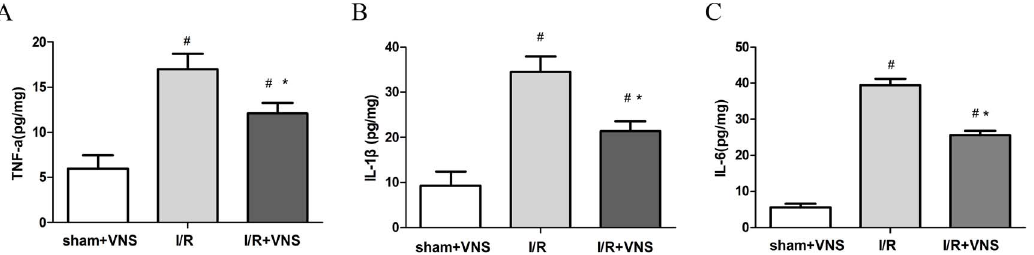
Figure 8. Effect of VNS on inflammatory cytokines in the ischemic penumbra at 24 h after reperfusion. The concentrations of TNF-a, IL- 1 b , and IL-6 of the peri-infarct region were measured by ELISA. A: TNF-a, B: IL-1 b , C: IL-6 at 24 h reperfusion in the peri-infarct region. Data are presented as mean 6 SEM (n=15 per group); *P , 0.05 vs I/R group, # p , 0.05 vs sham + VNS group.